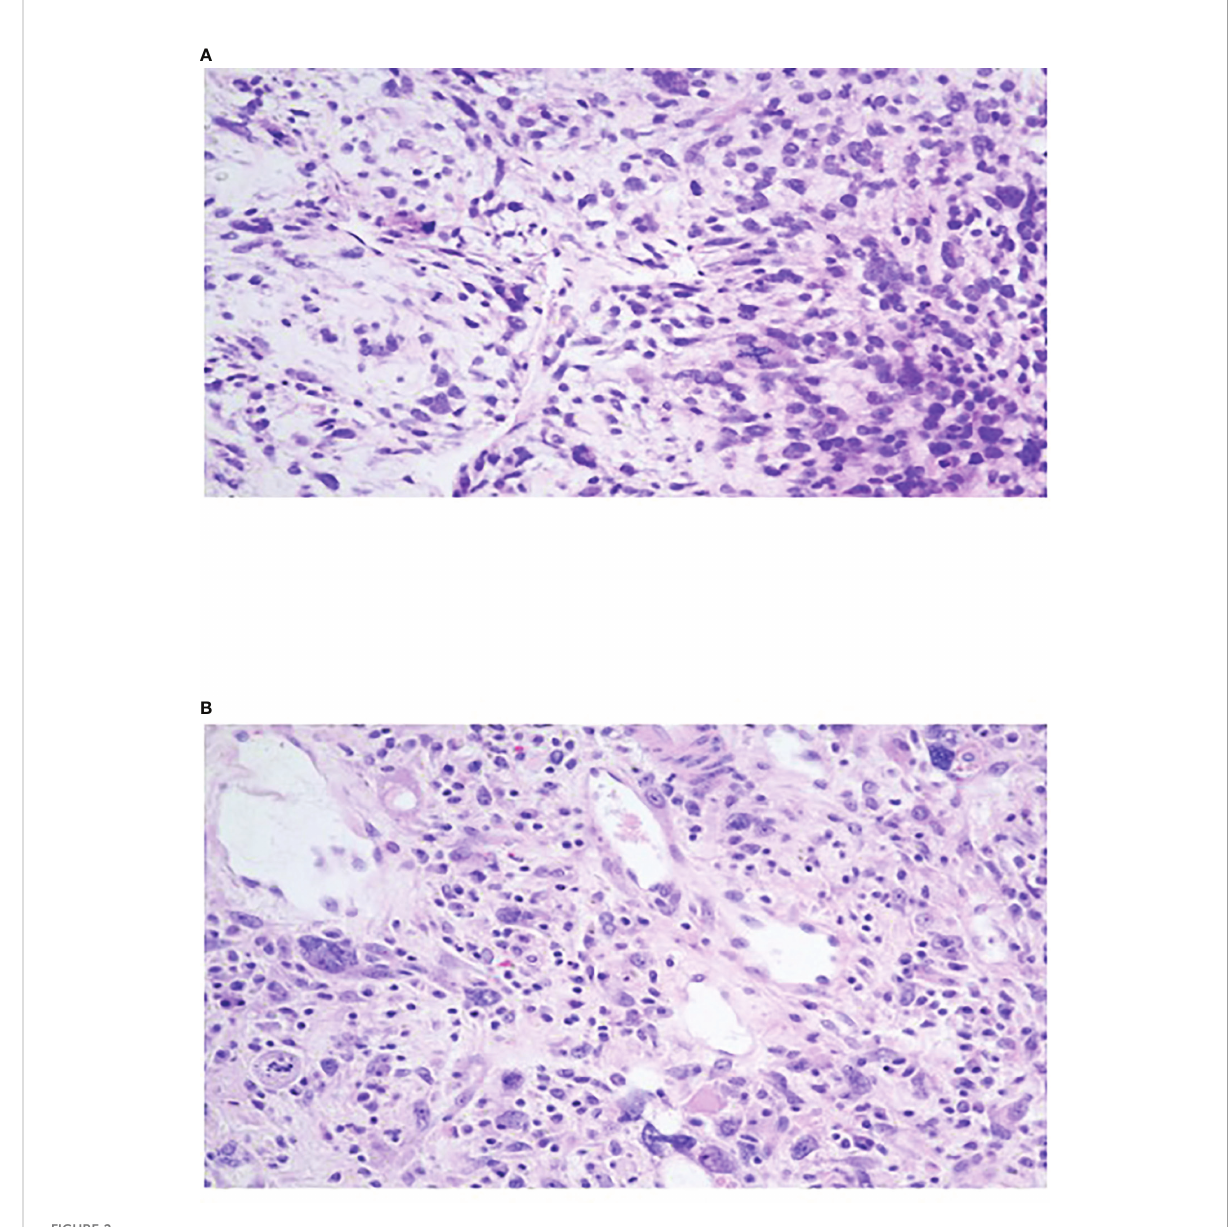
FIGURE 2 (A) Oval to stellate tumor cells with ill-de fi ned cell borders loosely distributed in myxoid stroma with marked nuclear pleomorphism, hyperchromasia and brisk mitotic activity. (B) Tumor cells within a fi broin fl ammatory background showing marked nuclear pleomorphism, hyperchromasia, and frequent multinucleated and bizarre giant cells. Cytoplasmic and extracellular eosinophilic globules